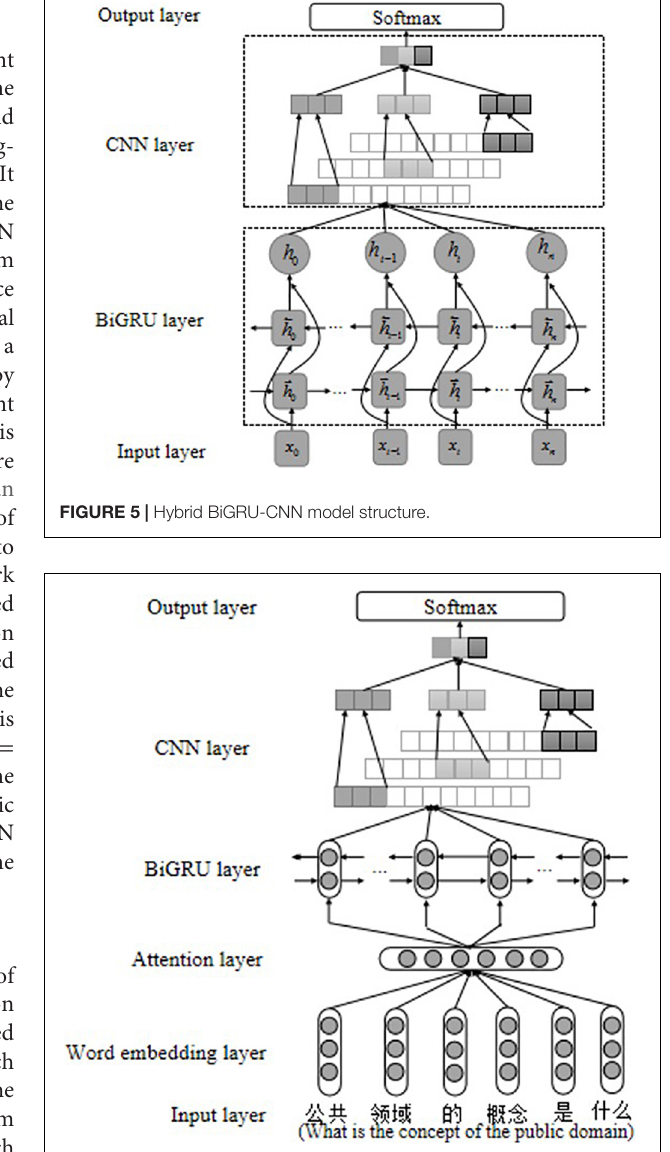
FIGURE 6 | AM-BiGRU-CNN model